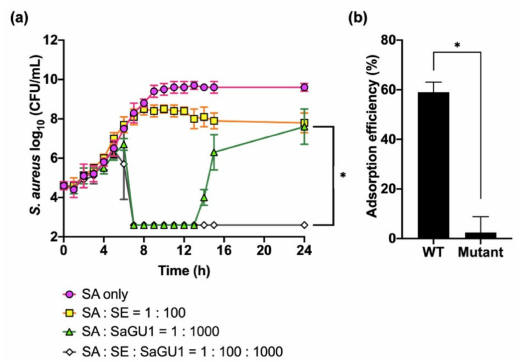
Figure 3. ( a ) The effect of phage SaGU1 on the growth of S. aureus SA-1 co-cultured with S. epider- midis SE-4. The cultures were started with ~10 4 CFU/mL of S. aureus SA-1 and ~10 6 CFU/mL of S. epidermidis SE-4 and appropriate amounts of phage SaGU1. The number of cells was determined by colony counting on LB plates with LVFX. The data are presented as the mean ± SD of at least three independent experiments. The detection limit was 4.0 × 10 2 CFU/mL. ( b ) Adsorption assay. The adsorption efficiencies of SaGU1 for S. aureus SA-1 (WT) and S. aureus recovered from the culture of “SA: SaGU1 = 1:1000” (Mutant) after 24 h are shown. The data are presented as the mean of three independent experiments, and the error bars represent the SD. Student’s t -test was used to determine significance. (*, p <